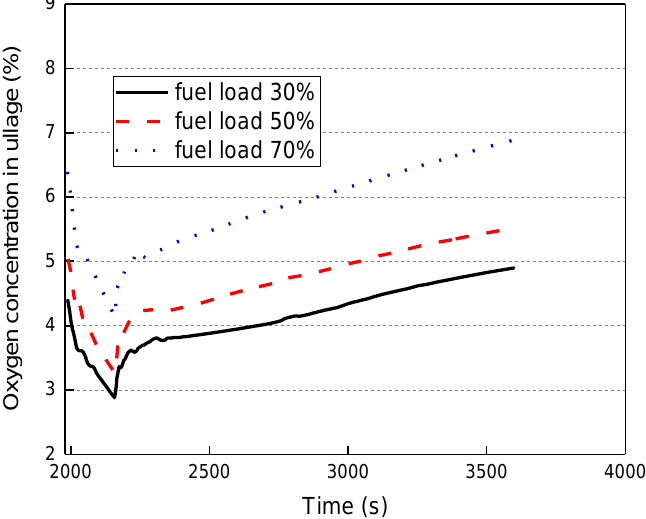
Figure 7. Distribution of oxygen concentration during nitrogen filling protection. The variation in oxygen concentration in the ullage from the beginning of the tactical descent to the end of flight with nitrogen filling protection at different fuel loads is shown in Figure 8.